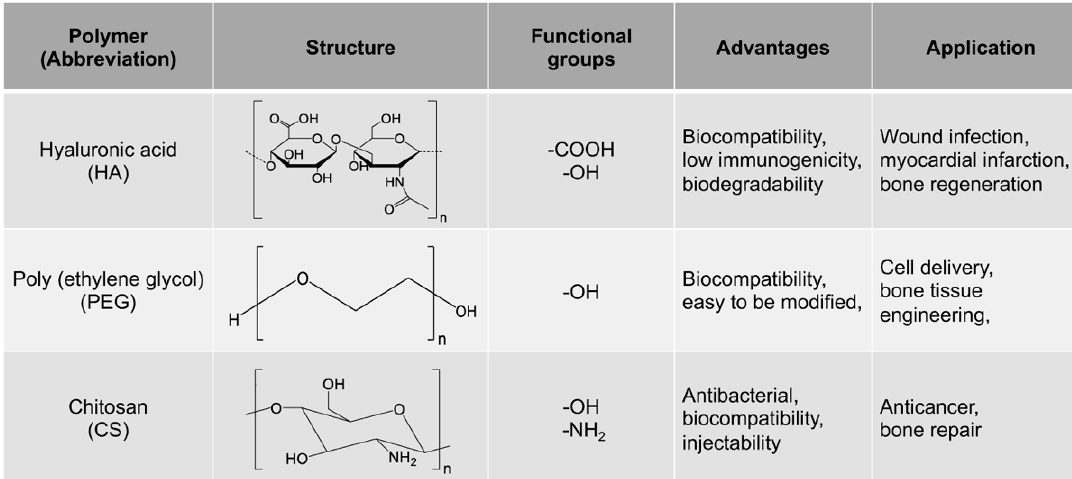
Figure 2. Polymers for MMP-cleavable peptides-based hydrogels.